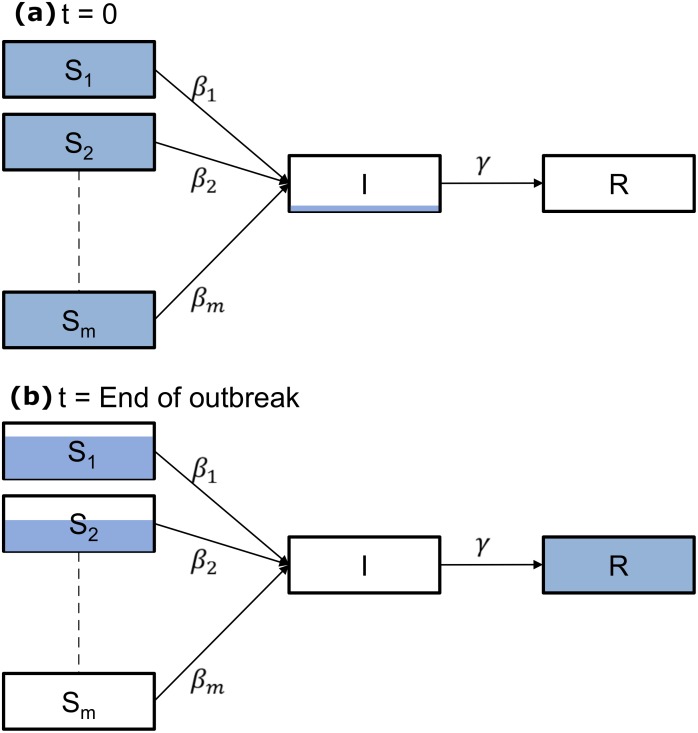
Model sketch.The SIR model with susceptibility sub-populations used in this work. (a) Initially, individuals belong to one of the susceptibility sub-populations. Infection is seeded by a initially infected people. (b) At the end of the epidemic, all individuals are either recovered or have never been infected.